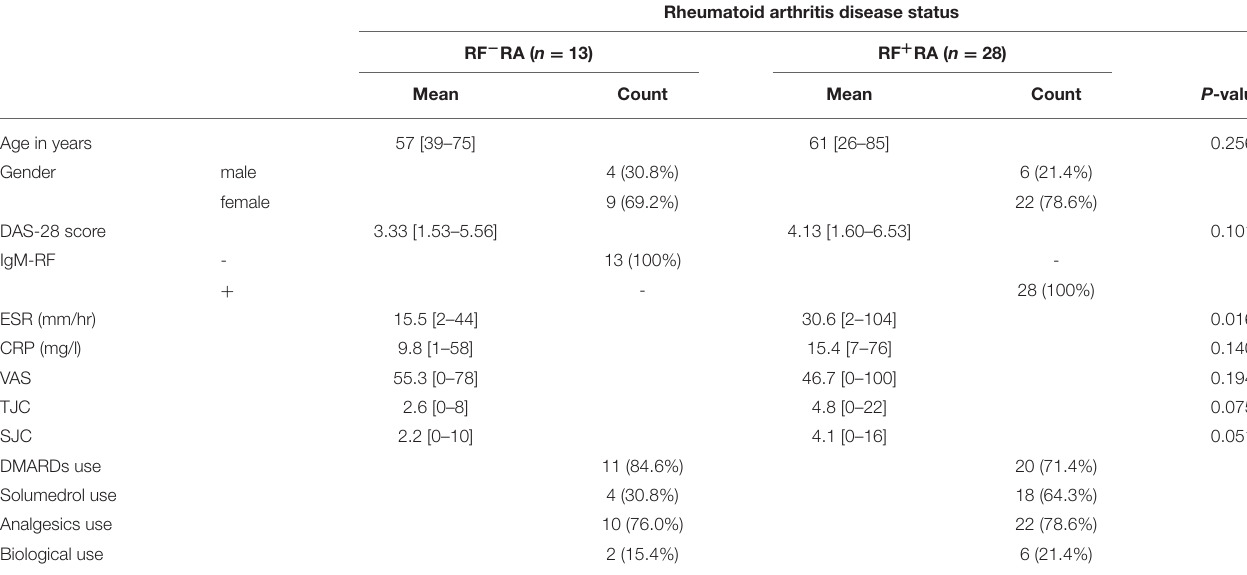
TABLE 1 | Clinical characteristics of RA patients at time of blood